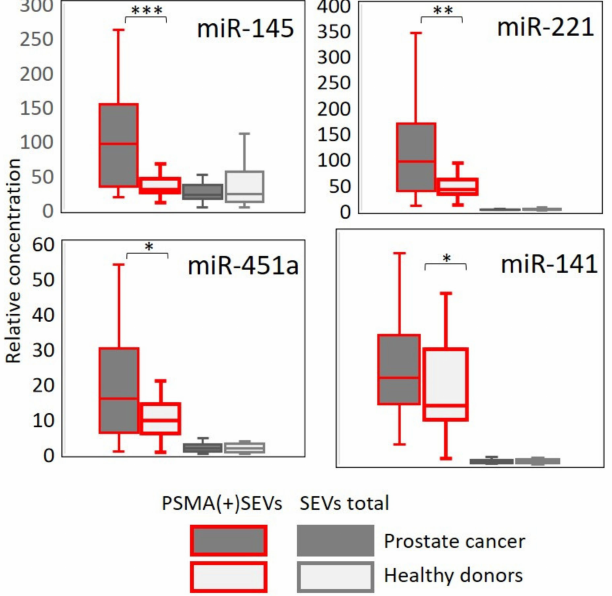
Figure 7. Comparative analysis of mir-145, mir-221, mir-451a, and mir-141 in plasma SEVs of prostate cancer patients and healthy donors. Plasma samples from PC patients’ (n = 55) and healthy donors’ (n = 30) RNA were used. From each sample, the total population plasma SEVs and PSMA(+)SEVs were assayed. RNA was isolated and RT-PCR analysis of miR-145, miR-221, miR-451a, miR-141, and miR-93 was performed in duplicate. Results were normalized versus miR-93 and averaged within groups. Statistical significance between paired groups (PC vs. healthy donors) was determined using the Mann–Whitney test: * p < 0.05, ** p < 0.005, and *** p <